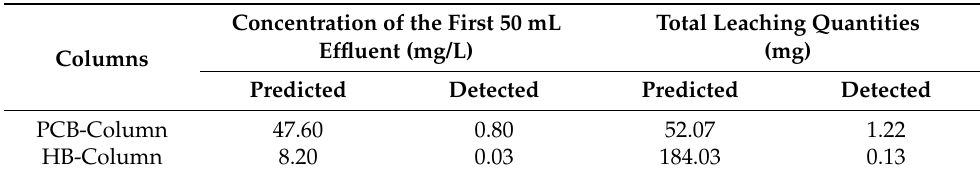
Table 6. Comparison of predicted and detected concentrations and total release of PO 43- in column experiments.